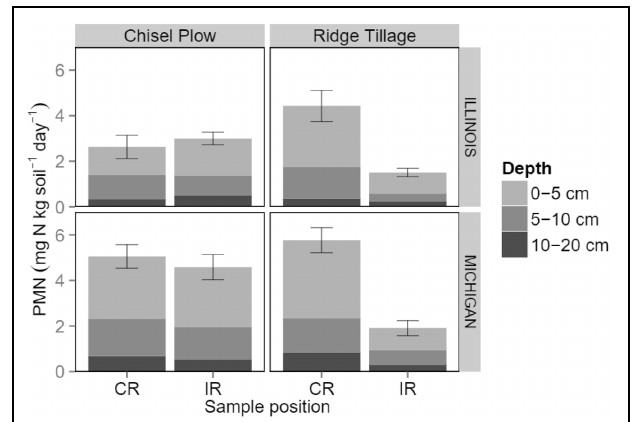
FIGURE 2 | Potentially mineralizable N (PMN) at different depths and positions (CR: crop row; IR: inter-row) in two maize-soybean cropping systems during mid-summer. Error bars represent ± 1 SE. Adapted from Kane et al.